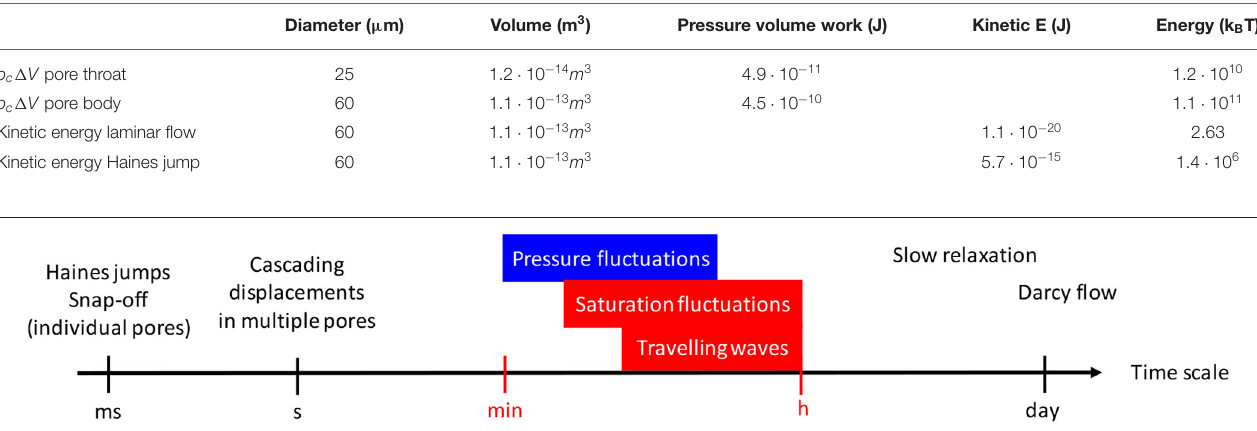
FIGURE 10 | Time scale of the fluctuations observed in this work (red) put into perspective with other characteristic times scales encountered in porous media. Displacement events in individual pores such as Haines jumps and snap-off are on the time scale around 1ms ( Armstrong et al., 2015). Cascading displacement events involving multiple pores show a relaxation time scale around one second (Armstrong et al., 2014a). The time scale of pressure fluctuations observed in this work and related studies ( Spurin et al., 2020; Menke et al., 2021) are on the order of 1–20min and the saturation fluctuations and traveling saturation waves from Figure 6 are on the order of 30–60min. That is still faster than the slow relaxation behavior observed in Schlüter et al. (2017). Darcy flow, e.g., at typical field rates of 1 ft/day over a characteristic length scale such as a capillary dispersion zone of 3–5 centimeters length occurs at